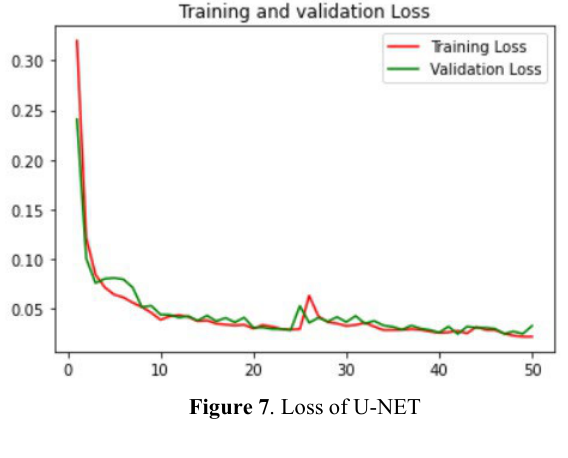
Figure 7 . Loss of